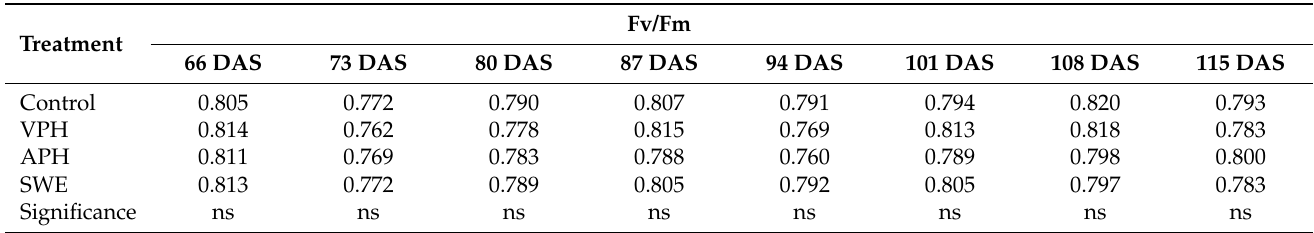
Table 2. Effect of biostimulant treatments on maximum quantum use efficiency of PSII (Fv/Fm) of chicory leaves during the greenhouse trial.